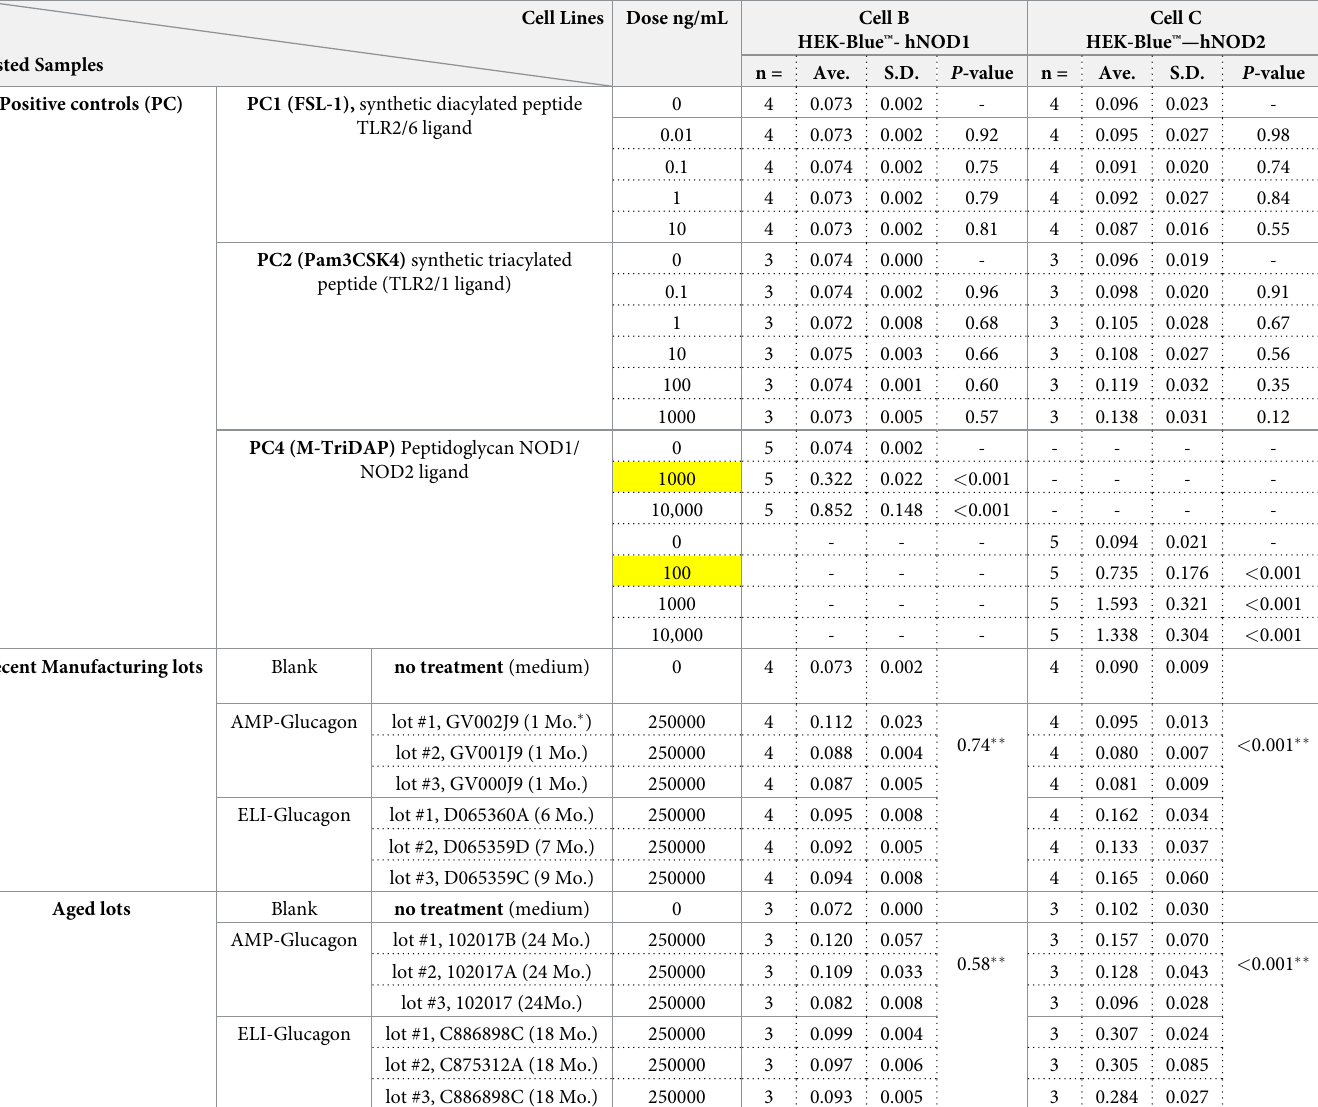
Table 4. Innate immunity assay with HEK-Blue ™ -hNOD1 and hNOD2.